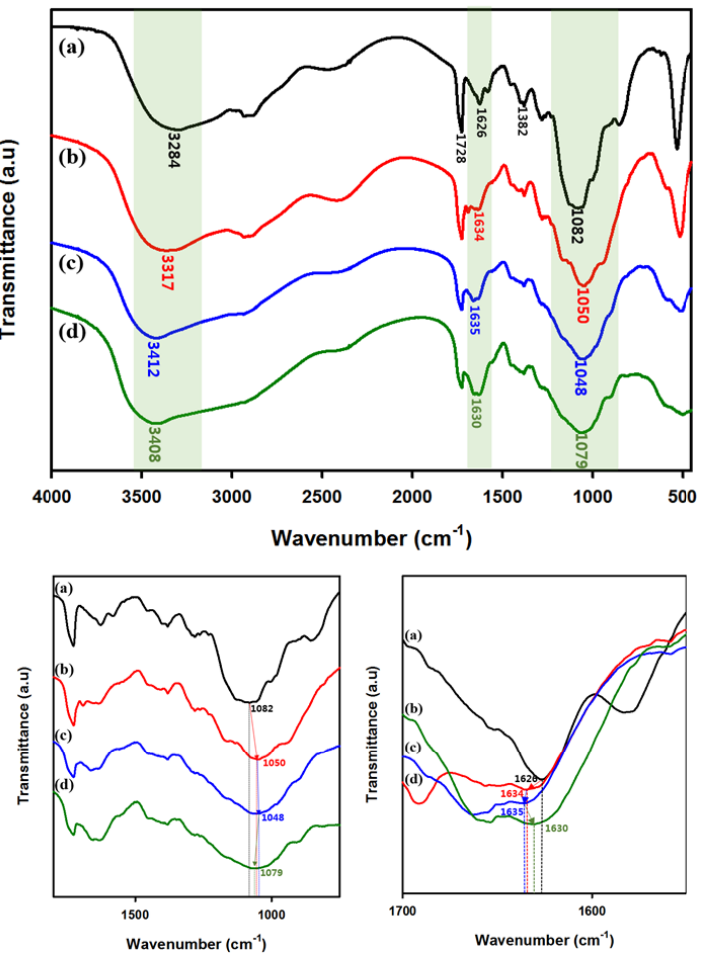
Figure 3. Fourier transform infrared (FTIR) spectra: ( a ) succinoglycan, ( b ) SC 13.2 , ( c ) SC 26.4 , and ( d ) SC 52.8 .